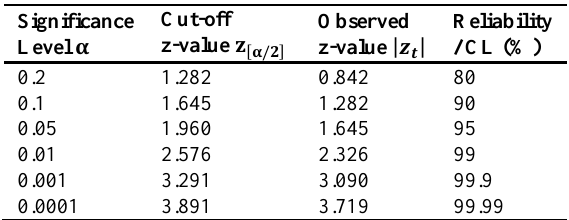
Table 1. Some common Significance Level and the corresponding cut-off z-value, observed z-value, and reliability.